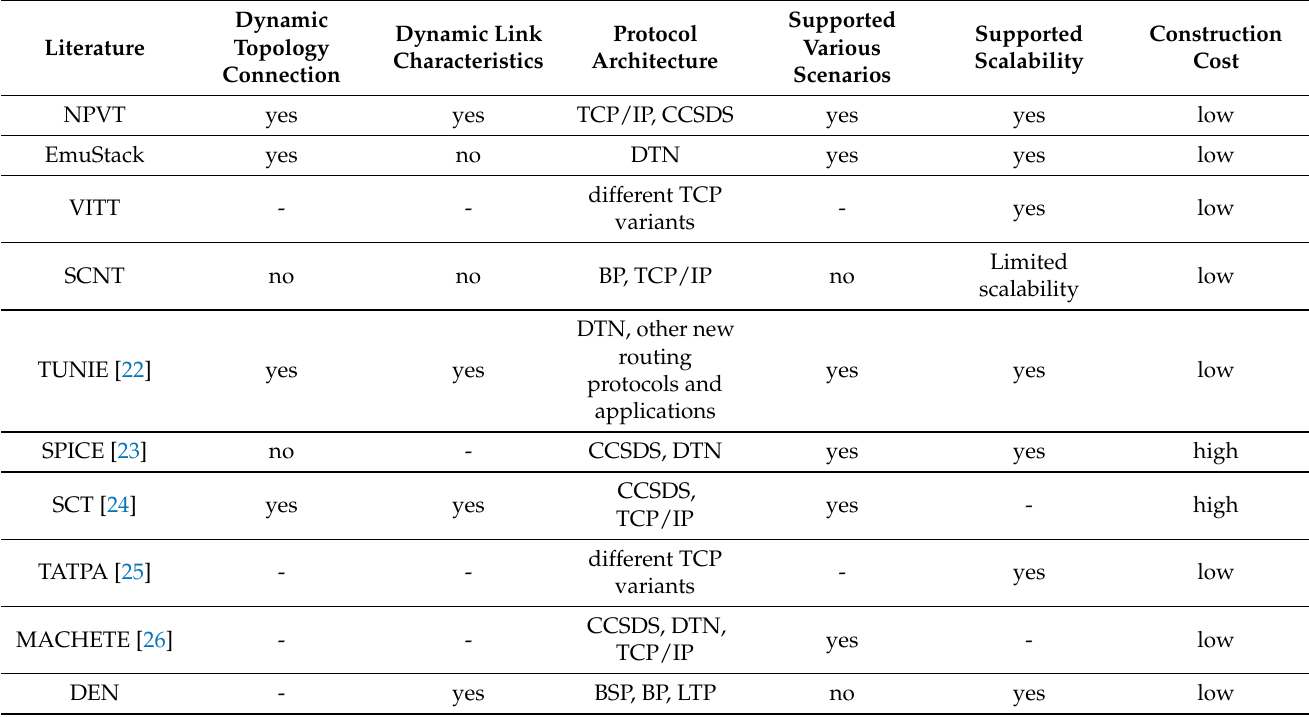
Table 1. Comparisons among existing space network emulation